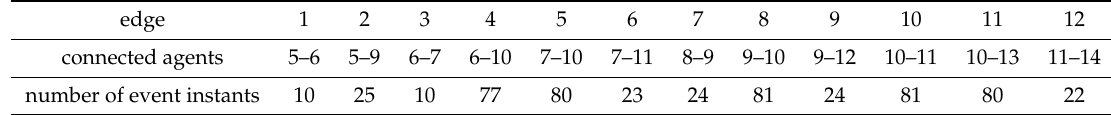
Figure 7. Event instants on edges 1–12 ( τ = 0.5, 50 s). Table 5. Number of event instants of each edge ( τ = 0.1, 50 s).